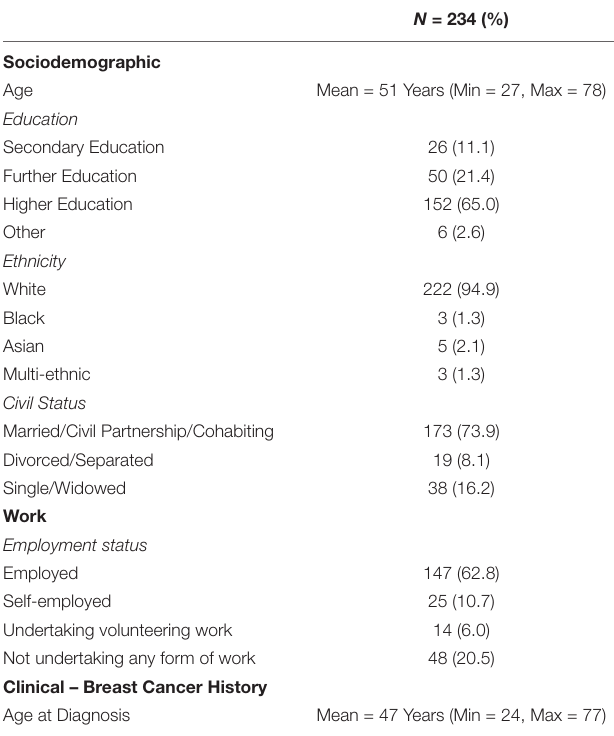
TABLE 1 | Participant demographics, clinical characteristics, and psychiatric